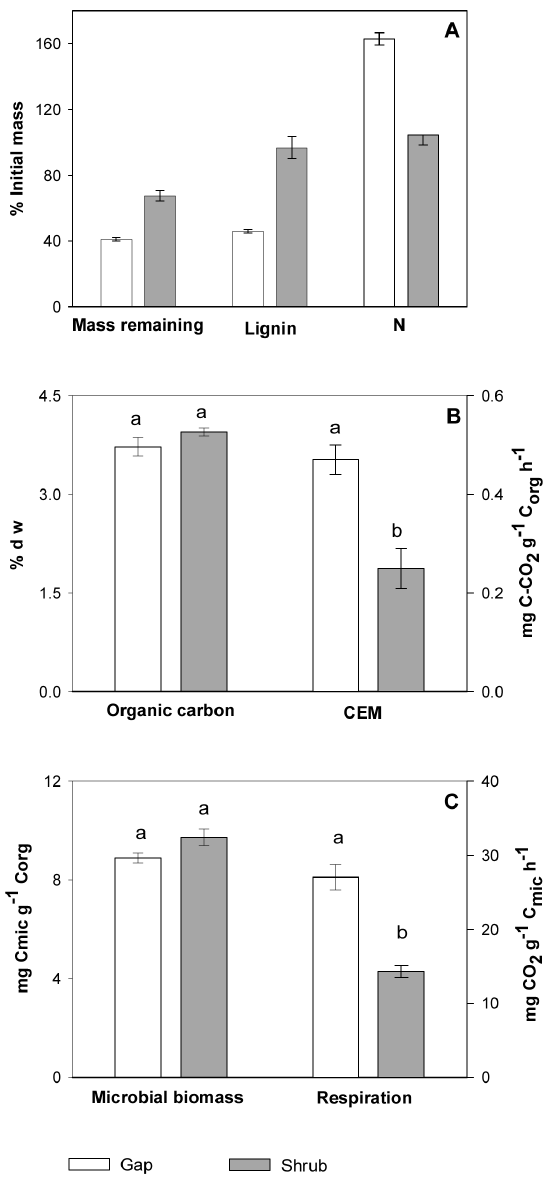
Fig. 5. Mass remaining (% initial mass), and lignin and nitro- gen amount (over % initial mass) after 215 days of incubation in laboratory microcosms; values are means of 7 measurements for mass remaining and mean of 3 measurements for lignin and nitrogen amount (A), Organic carbon (%) and coefficient of endogenous mineralization (CEM) (B), microbial biomass and respiration (C), measured on fresh soil samples collected on De- cember 2004 in gaps and in the understorey of Phillyrea shrubs; values are mean of 5